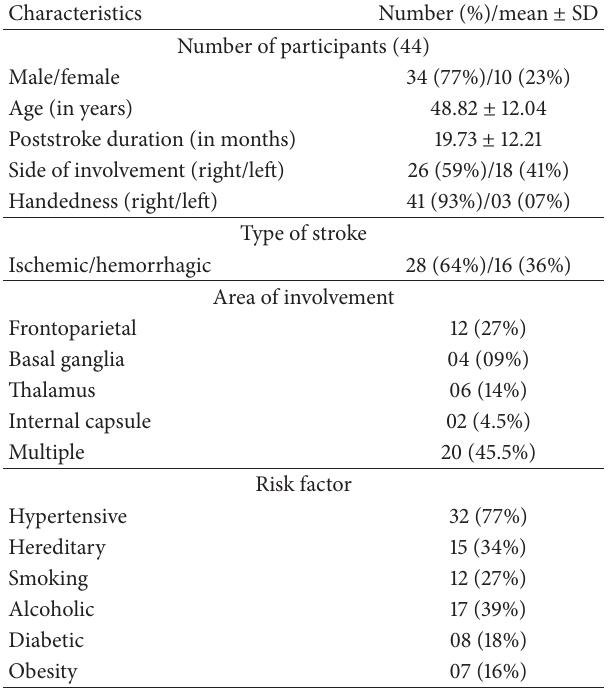
Table 1: Demographic characteristics of the participants.